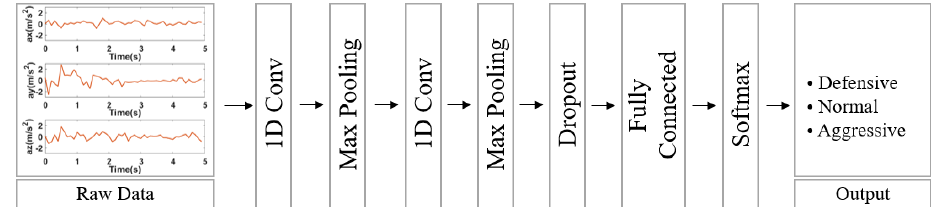
Figure 3. 1-Dimensional Convolution Neural Network (1D-CNN) structure [39].